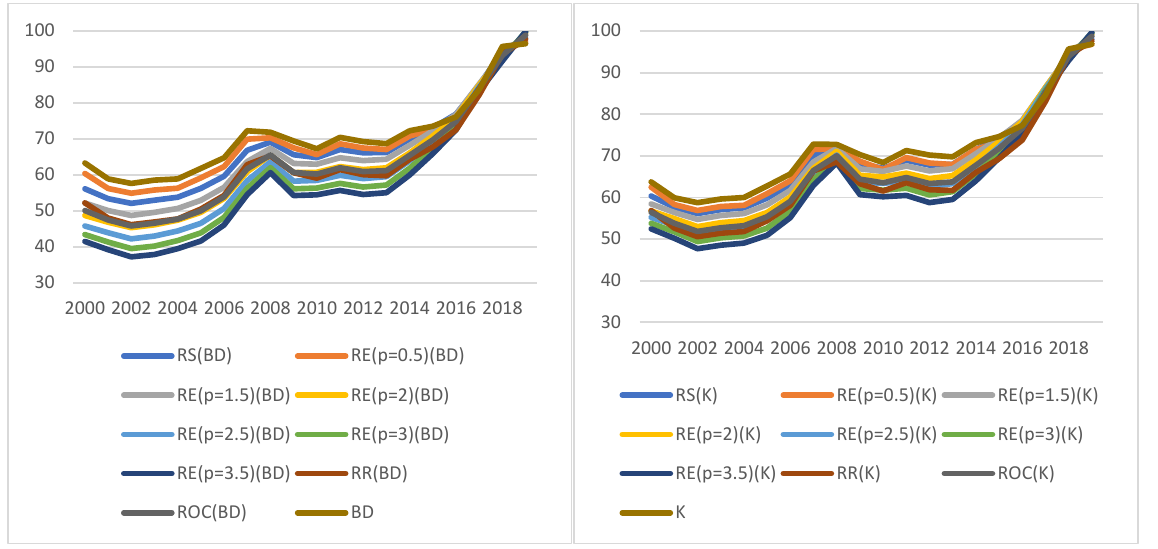
Figure 4. Indicator values for the economic KPI ( 𝐾𝑃𝐼 𝑏𝑒𝑠𝑡 𝐸 ). Source: a uthors’ own material based on the GUS data.